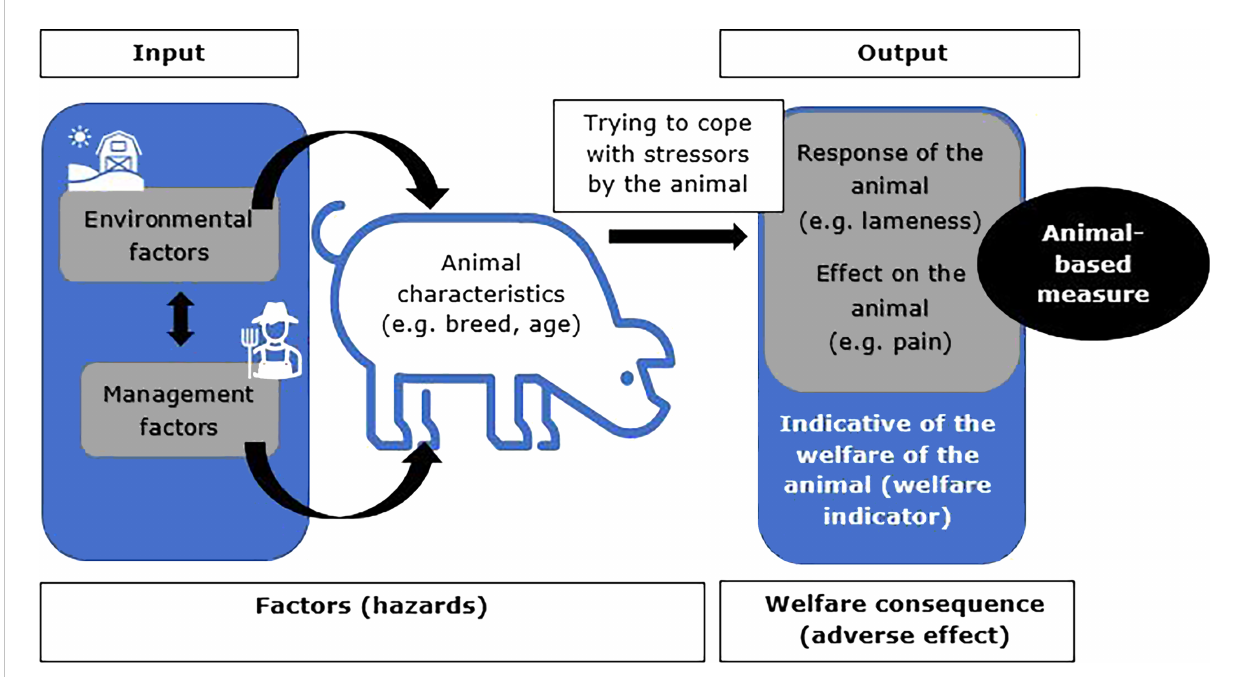
FIGURE 3 Overview of the factors and their relation on in fl uencing the animal ’ s welfare, including the indicators for welfare, adjusted from EFSA (2012f). This fi gure represents a negative effect and how different factors can have a negative in fl uence; however, a welfare consequence can also be positive, as certain factors can have a positive